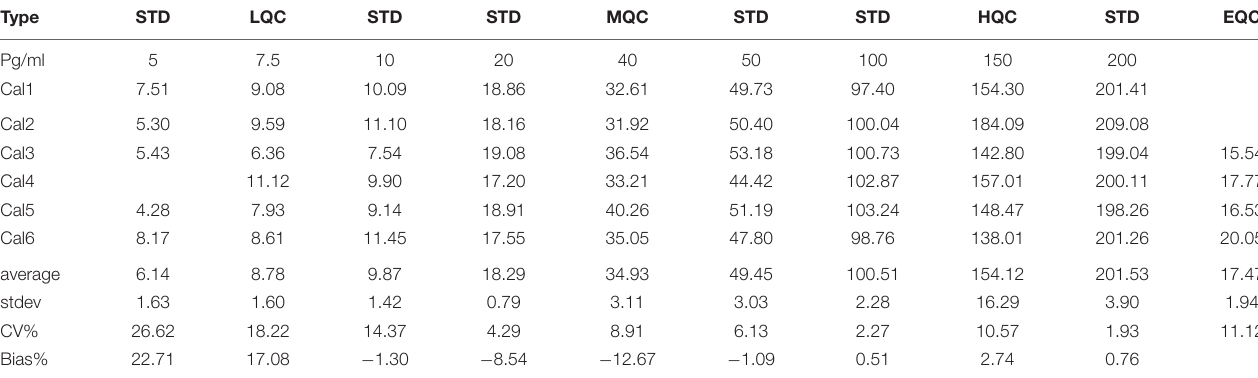
TABLE 3 | Analytical performance characteristics of the LRRK2 SISCAPA assay using recombinant LRRK2 and an endogenous QC (EQC) CSF sample. Type